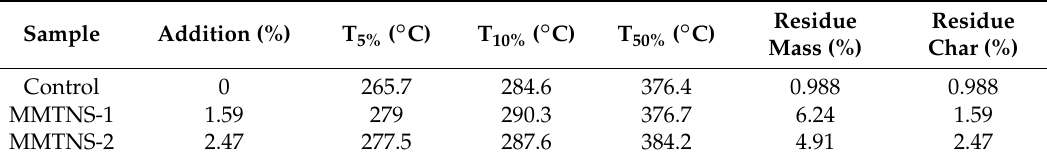
Figure 4. TGA ( a ) and DTG ( b ) curves of control and coated FPU foams under N 2 atmosphere. Table 1. TGA data of control and coated FPU